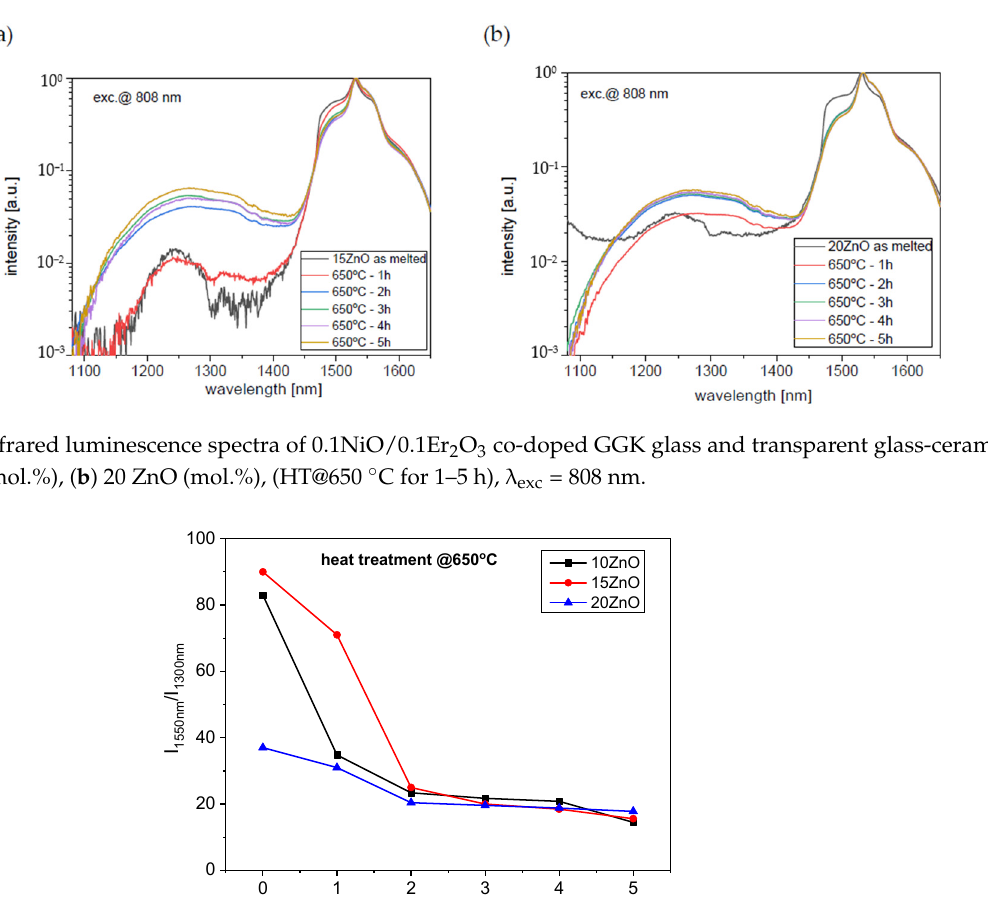
Figure 9. ( a ) Infrared luminescence spectra of 0.1NiO/0.1Er 2 O 3 co-doped GGK glass and transparent glass-ceramics with 10 ZnO (mol.%), (HT@650°C for 1–5 h), ( b ) simplified energy level diagram of the Ni 2+ and Er 3+ ions in the GGK glass-ceramics host with possible transitions and Ni 2+ to Er 3+ energy transfer, λ exc = 808 nm.